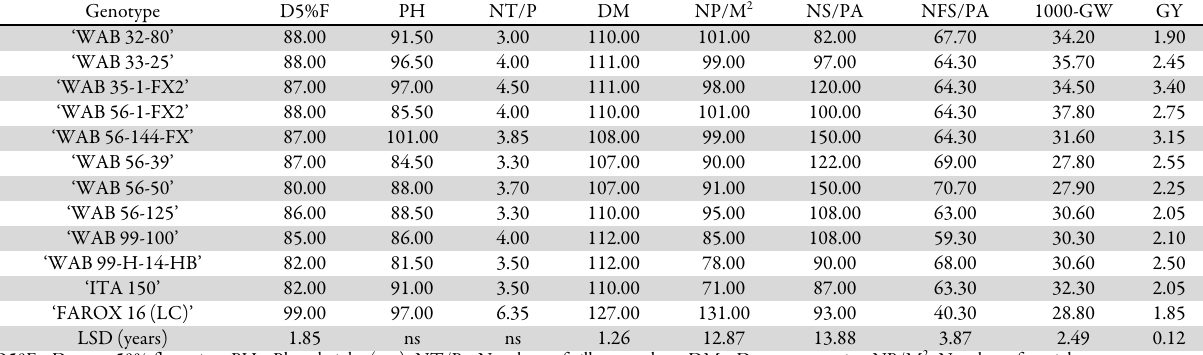
Table 3. Agronomic traits performance of the 12 rice genotypes for the two years combined